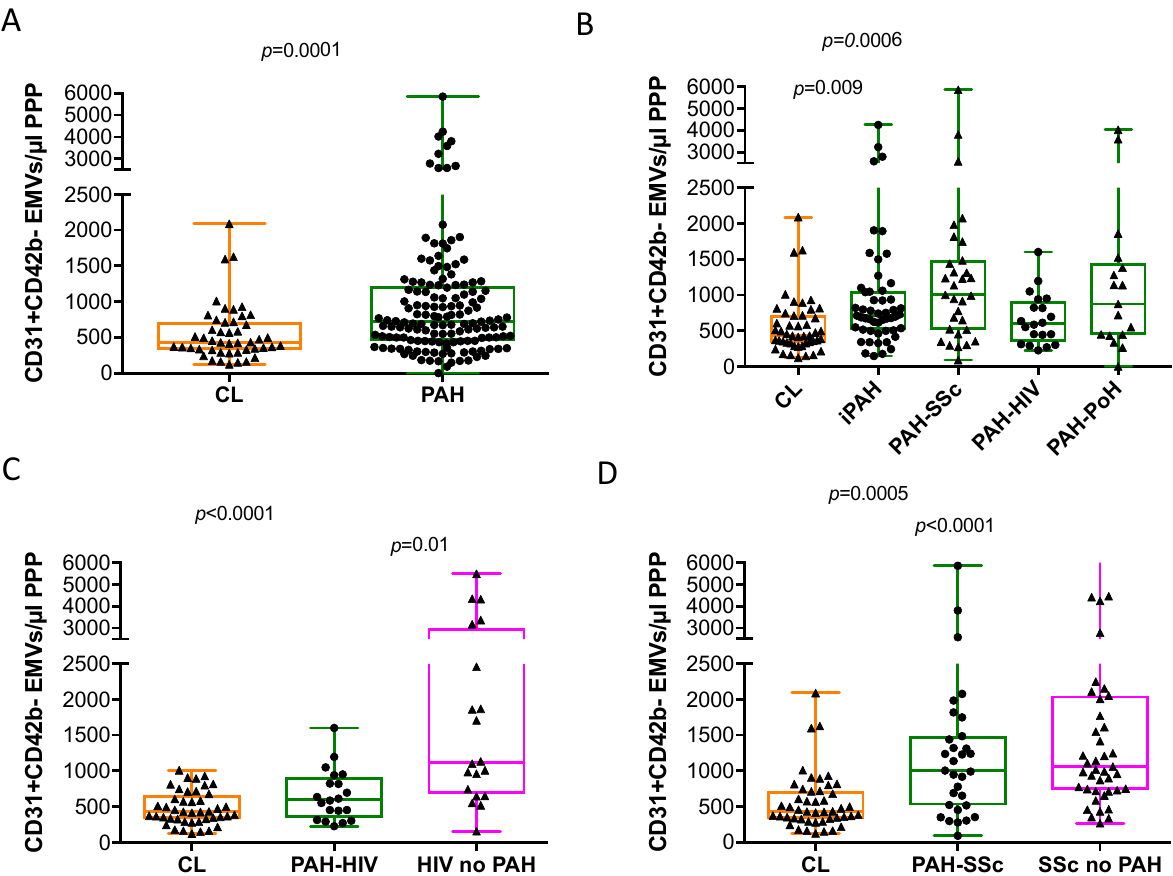
Figure 1. Number of circulating endothelial microvesicles (EMVs) in pulmonary arterial hypertension, scleroderma and HIV infection and healthy controls. Number of ( A ) CD31 + CD42b − endothelial microvesicles (EMVs), expressed per μ L of poor platelet plasma, in pulmonary arterial hypertension (PAH) versus healthy controls; ( B ) number of CD31 + CD42b − EMVs in all the different PAH subtypes versus healthy controls; ( C ) number of CD31 + CD42b − EMVs in patients with, HIV infection or without associated PAH; ( D ) number of CD31 + CD42b − EMVs in patients with scleroderma, with or without associated PAH. The whiskers extend from the minimum to maximum points. Mann Whitney Rank Sum test and Kruskal-Wallis One Way Analysis of Variance and when significant, post-hoc Dunn’s multiple comparisons test. Table 3. Circulating endothelial microvesicles and progenitor cell